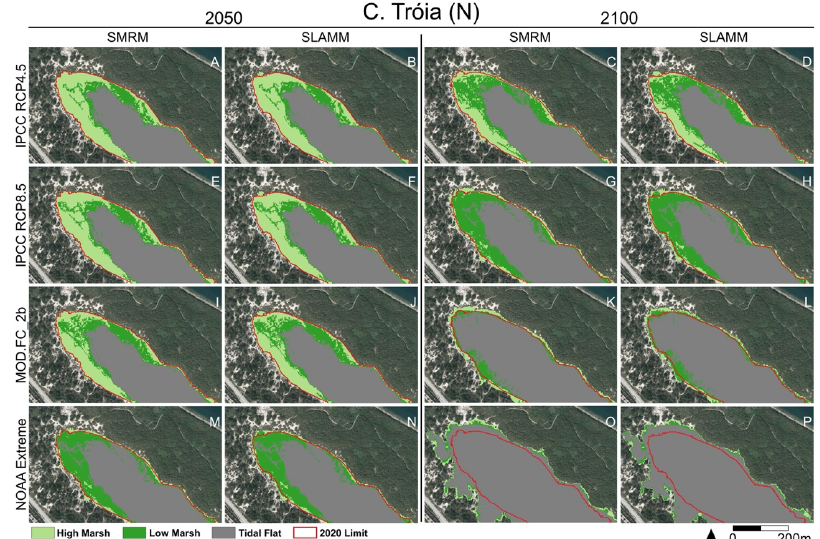
Figure 7. C. Tróia (N) salt marsh morphological maps for 2050 and 2100, using SMRM and SLAMM. Results are presented for the considered SLR scenarios: IPCC RCP4.5 ( A – D ), IPCC RCP8.5 ( E – H ), MOD.FC_2b ( I – L ), and NOAA Extreme ( M – P ).